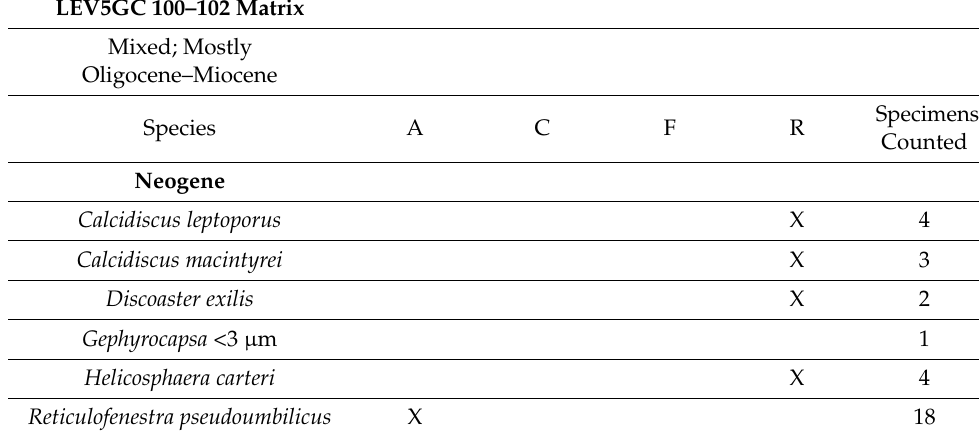
Table A23. Moscow